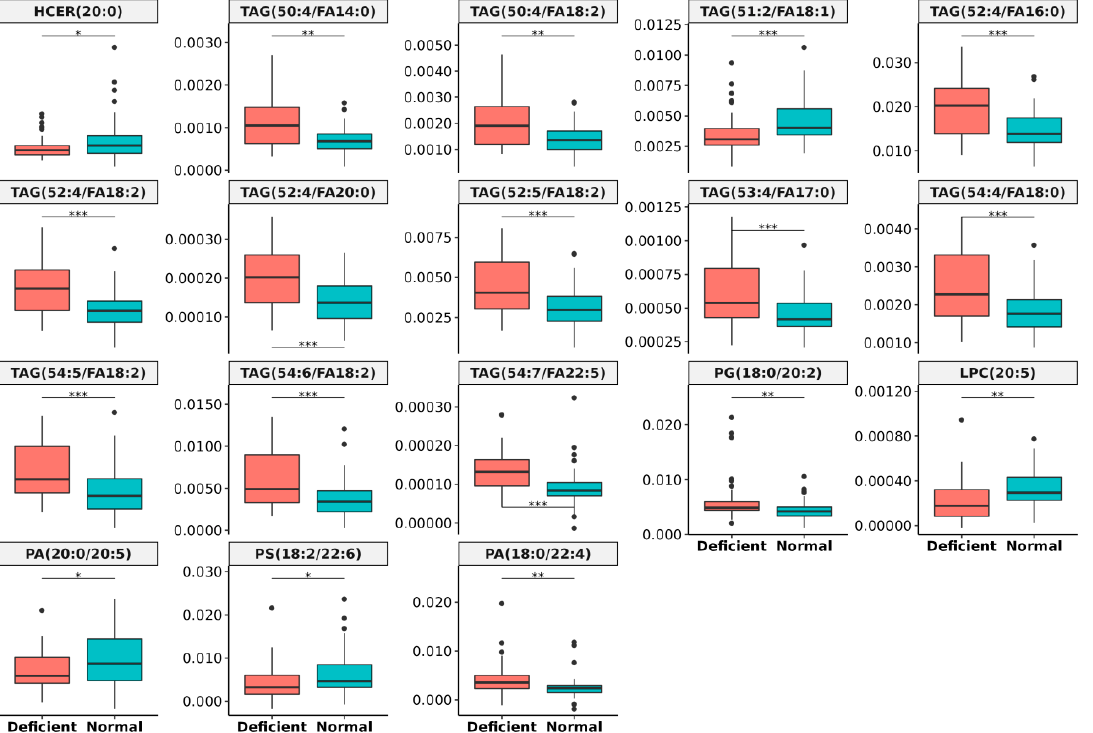
Figure 6. Significantly altered lipid species in vitamin B 12 deficiency. The significance level for different lipid species are represented by p-value ( * = p < 0.05, ** = p < 0.01 and *** = p <